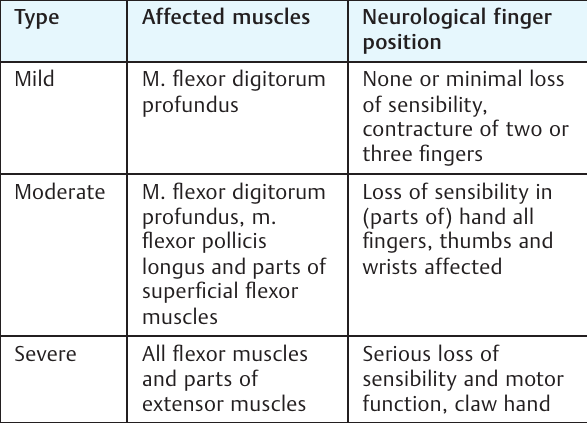
Table 1 Tsuge classi fi cation — Volkmann ischemic contracture